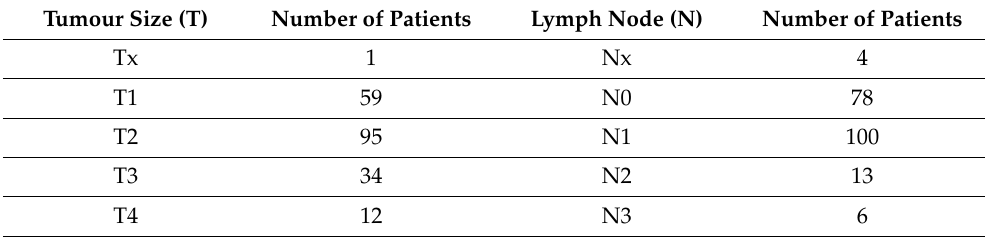
Table 1. Pathological features of early breast cancer patient tumors included in this study.